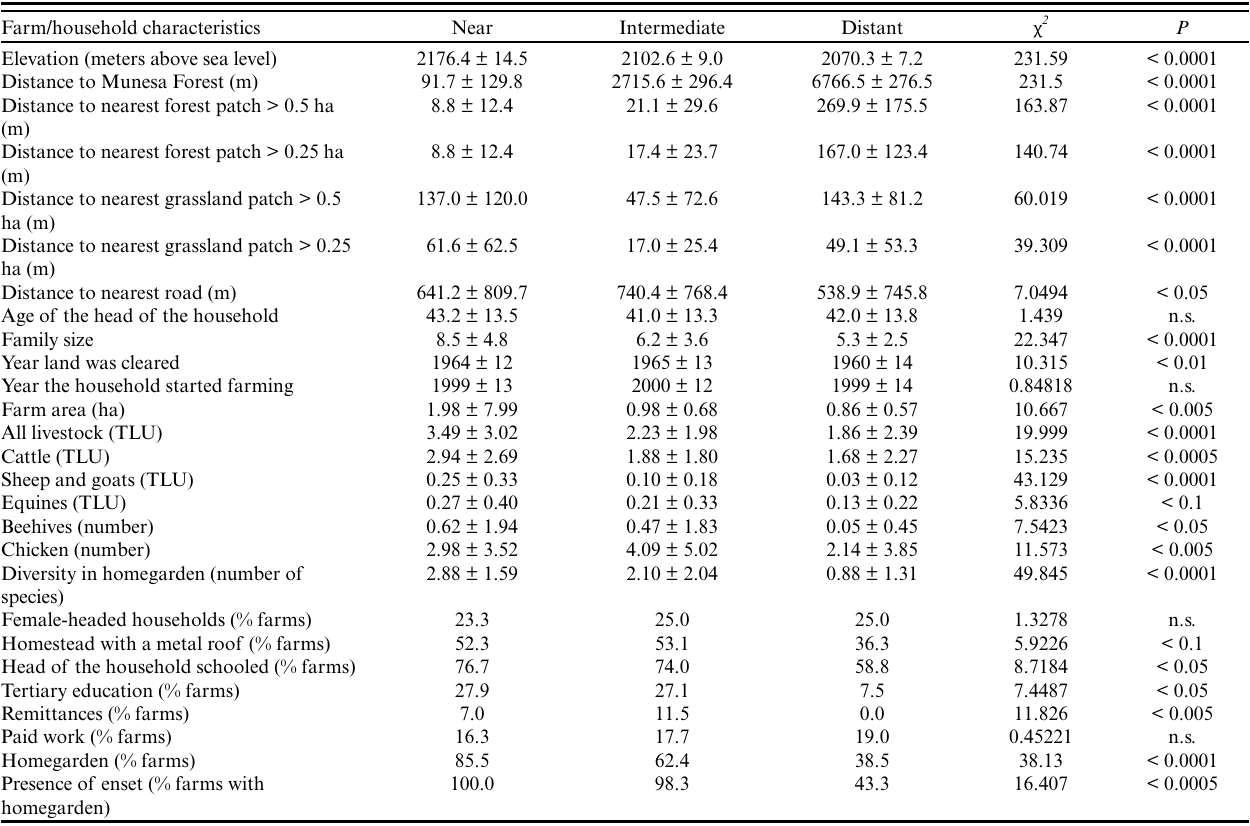
Table 2 . Comparison of locational, demographic, and farming system characteristics of the farming households in the three zones of the study area (near, intermediate, and distant to Munesa Forest). Units are given in parentheses. Standard errors are given after the “±” signs. χ 2 and P values are given for Kruskal–Wallis tests that compared medians between the three zones (TLU: tropical livestock